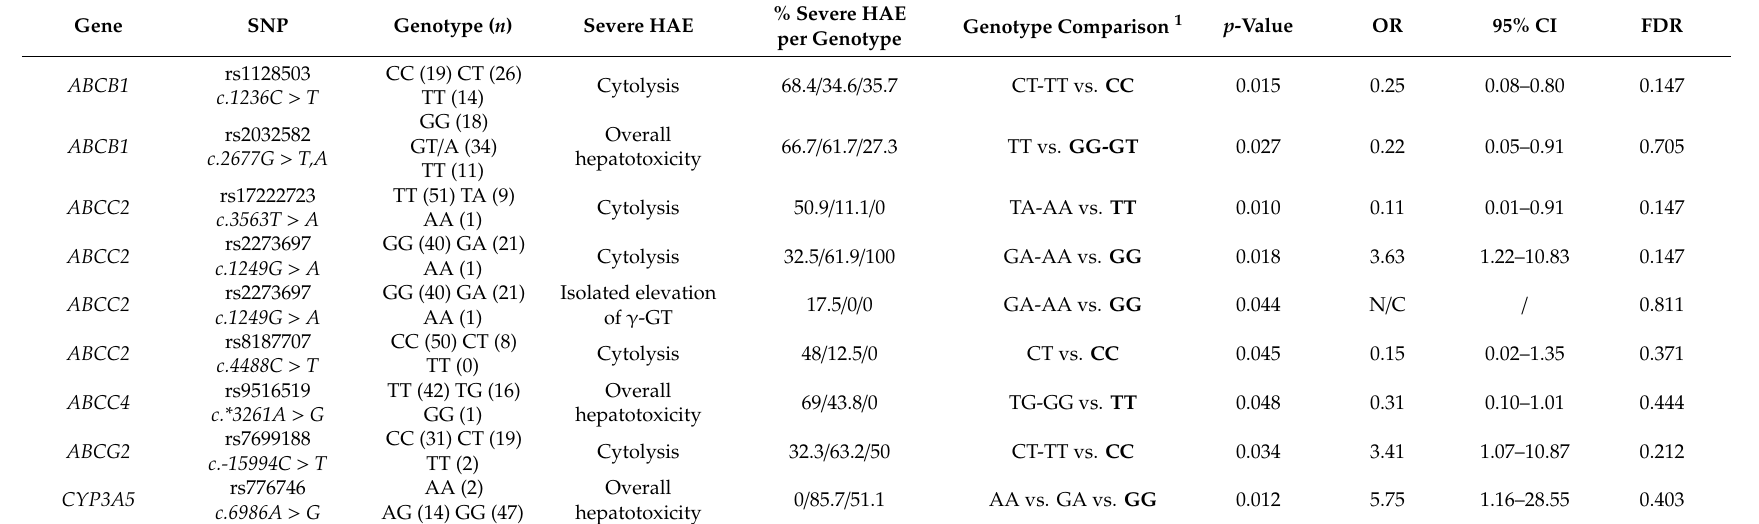
Table 2. Significant results ( p < 0.05) of the univariate analysis conducted on 35 candidate single-nucleotide polymorphisms (SNPs) selected in the literature.